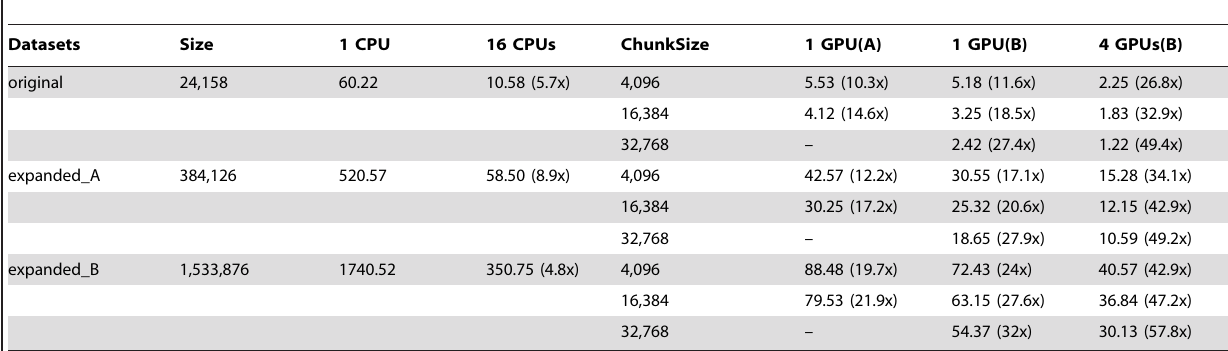
Table 2. Running time comparisons for the k NN graph computation on GTX 480 (GPU_A) and Tesla C2050 (GPU_B).